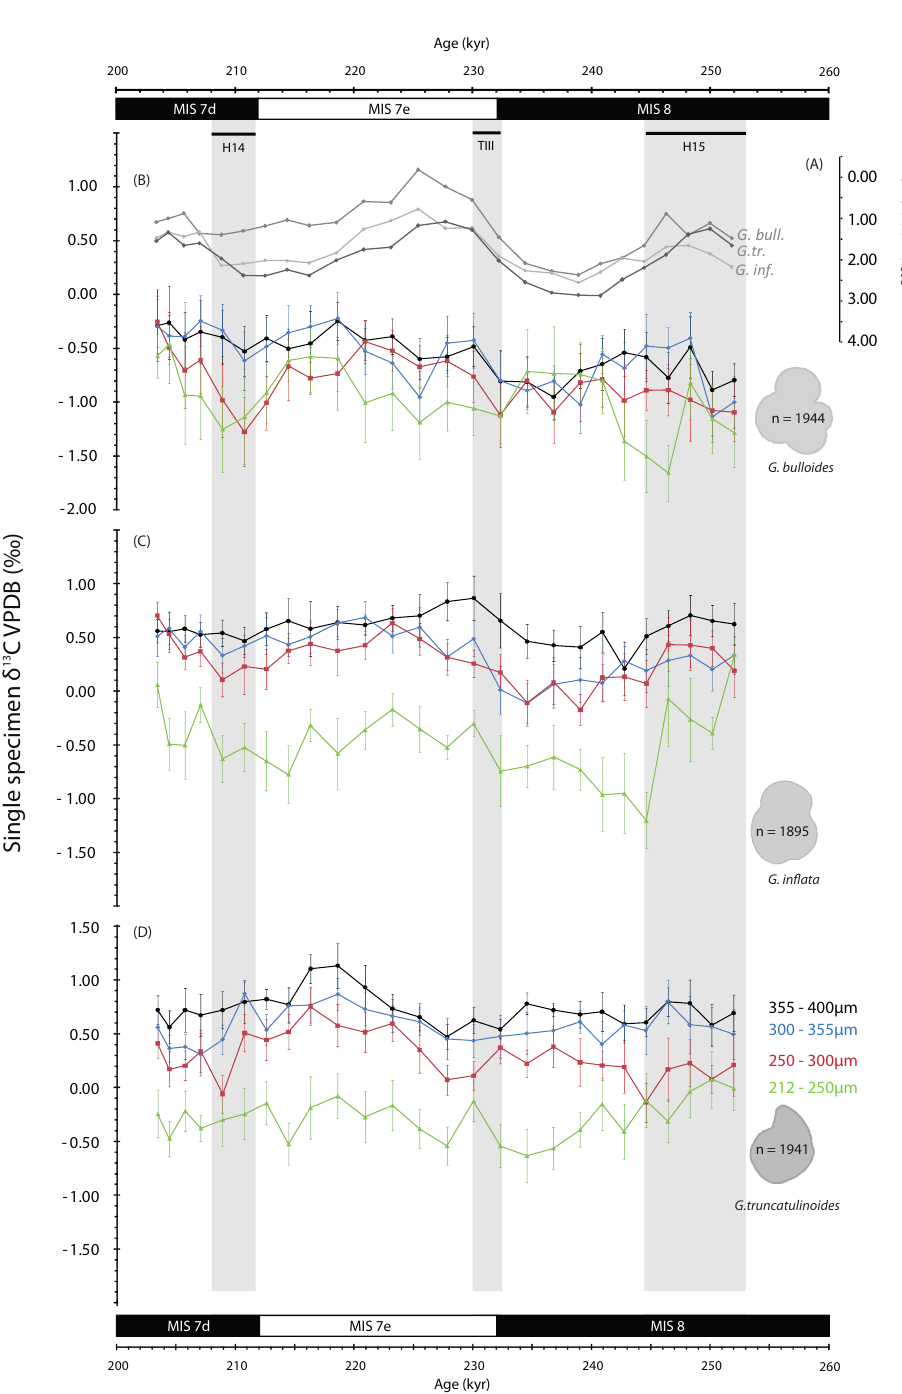
Figure 8. Mean carbon isotope values with 95% confidence intervals. (a) For comparative purposes the mean δ 18 O values for G. bulloides , G. inflata and G. truncatulinoides are shown. Mean δ 13 C values for (b) G. bulloides , (c) G. inflata and (d) G. truncatulinoides ; colour denotes size fraction. Highlighted regions represent the glacial and interglacial Heinrich events (H14 and H15) and Termination